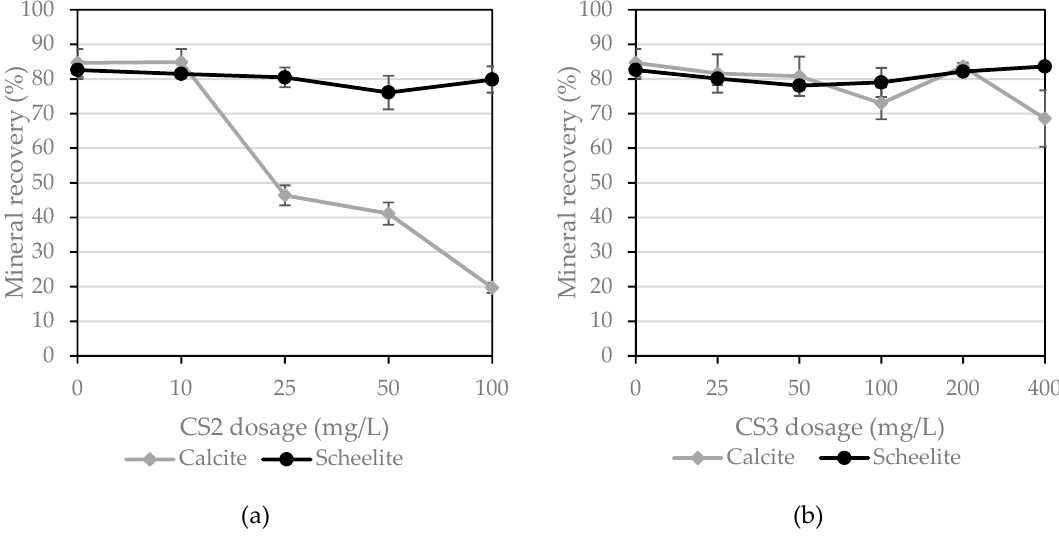
Figure 2. Single-mineral flotation recovery of calcite and scheelite depending ( a ) on the Levasil CS45-38P® (CS2) dosage and ( b ) on the Levasil CS50-34P® (CS3) dosage (at pH = 8, collector = 1 × 10 − 4 sodium oleate, error bars represent the 95% confidence interval). Table 1. Batch flotation reagent regime.